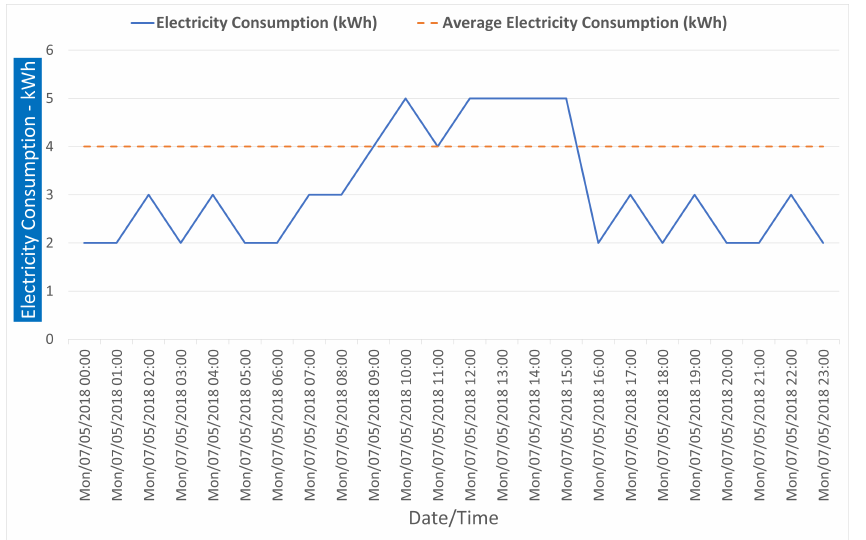
Figure 5. Hourly electricity consumption on the bank holiday 7 May 2018 of week 23 in the clinical engineering